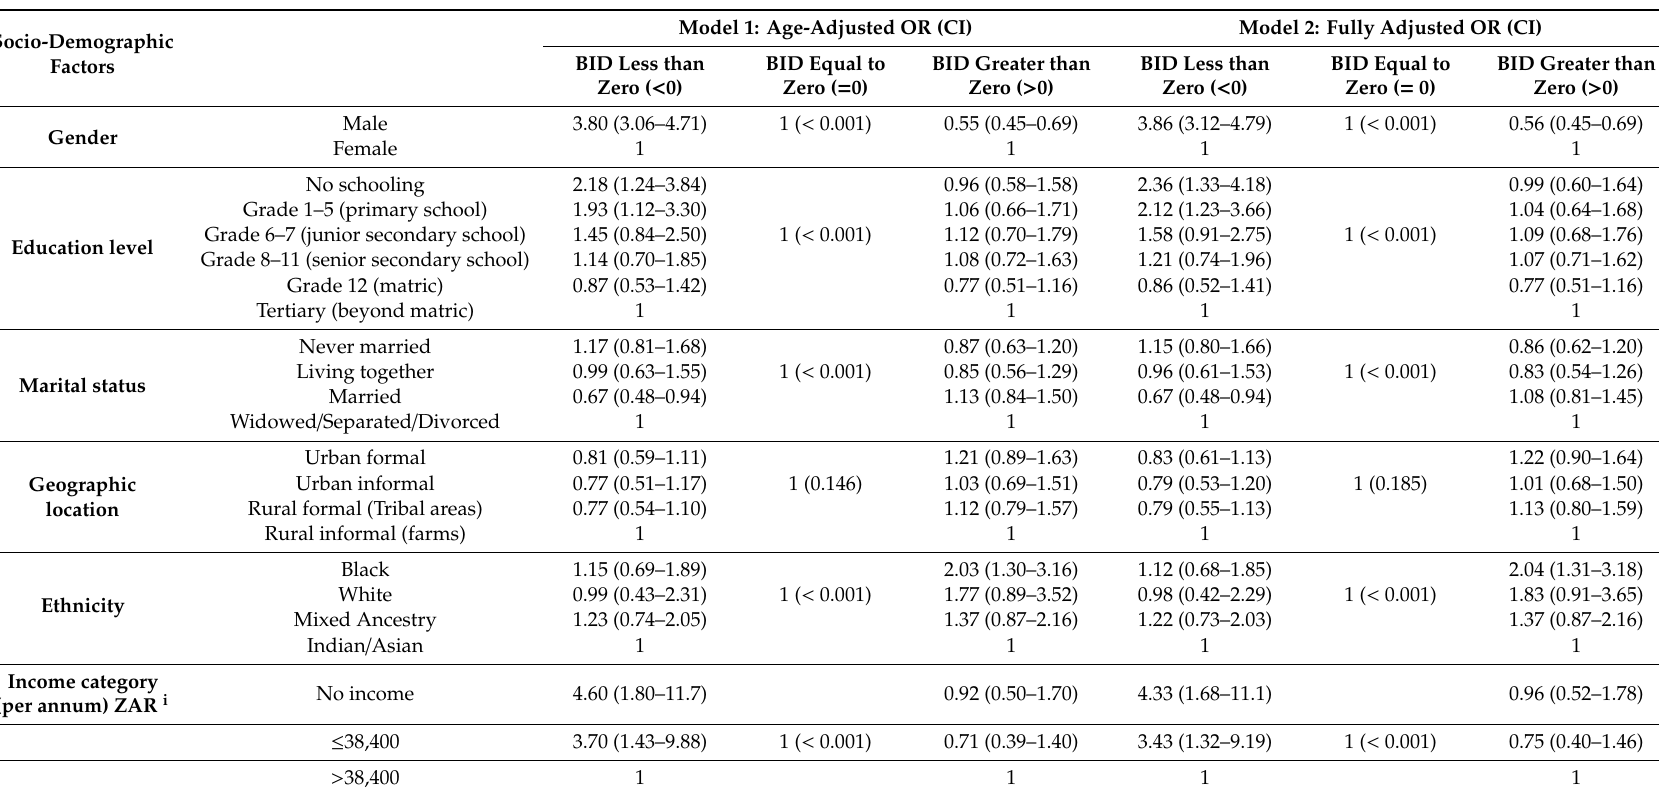
Table 3. The likelihood of body image discrepancy (BID) among participants from the SANHANES-1 survey by indicators of sociodemographic factors (age-adjusted and fully adjusted odds ratios from multinomial